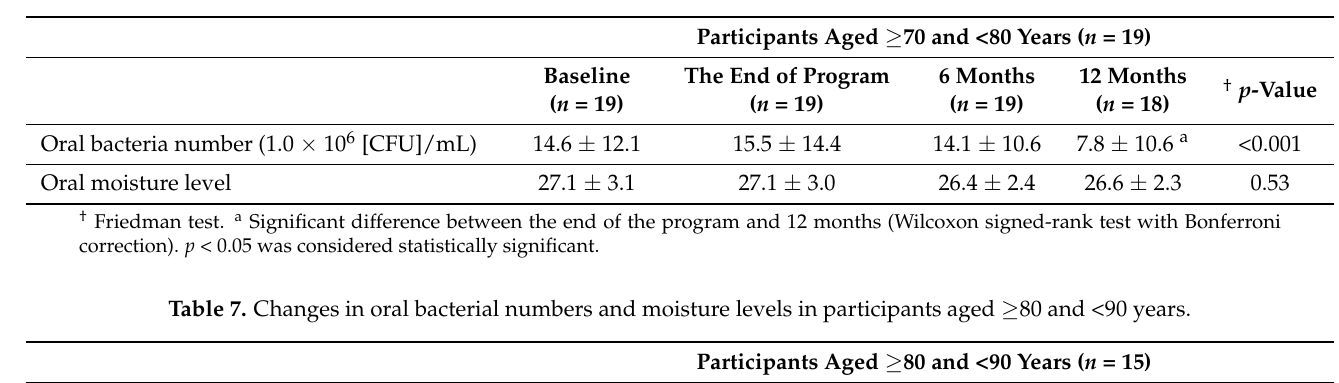
Table 6. Changes in oral bacterial numbers and moisture levels in participants aged ≥ 70 and <80 years.